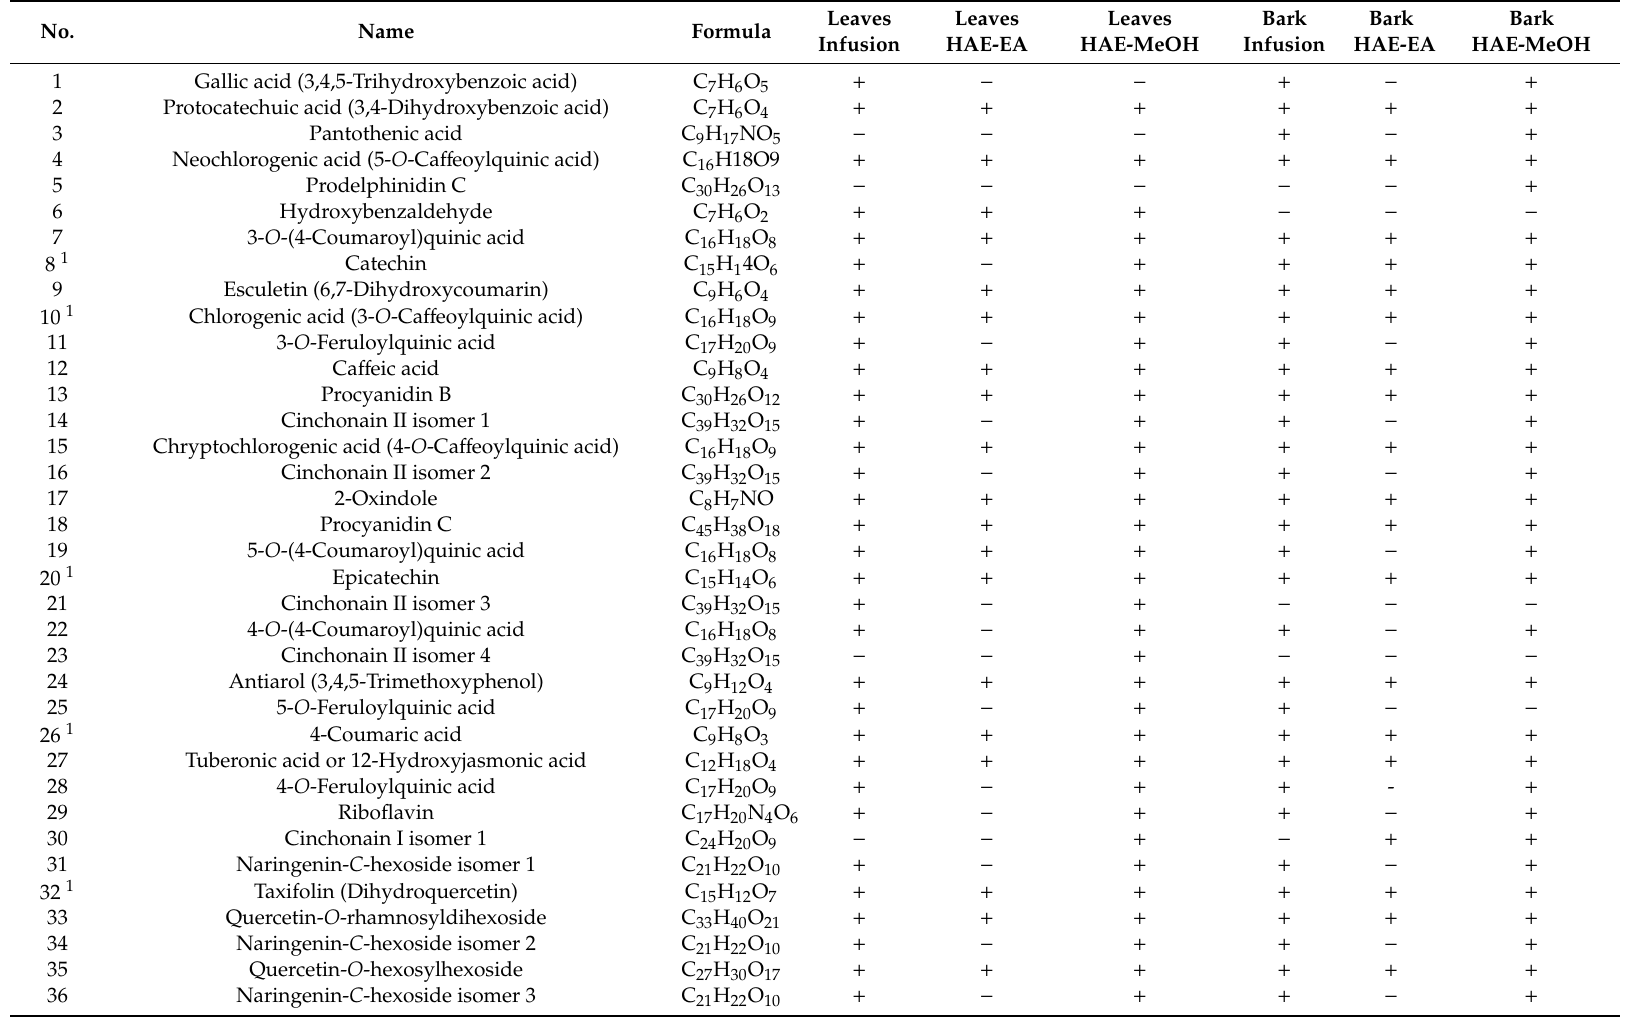
Table 2. Chemical composition of the tested